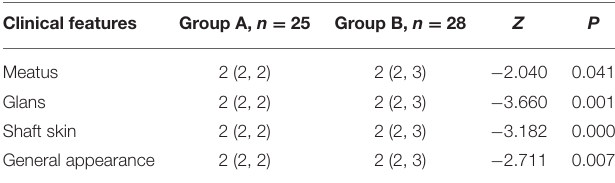
TABLE 5 | Comparison of two groups in PPPS by operators 3 months after operation. Clinical features